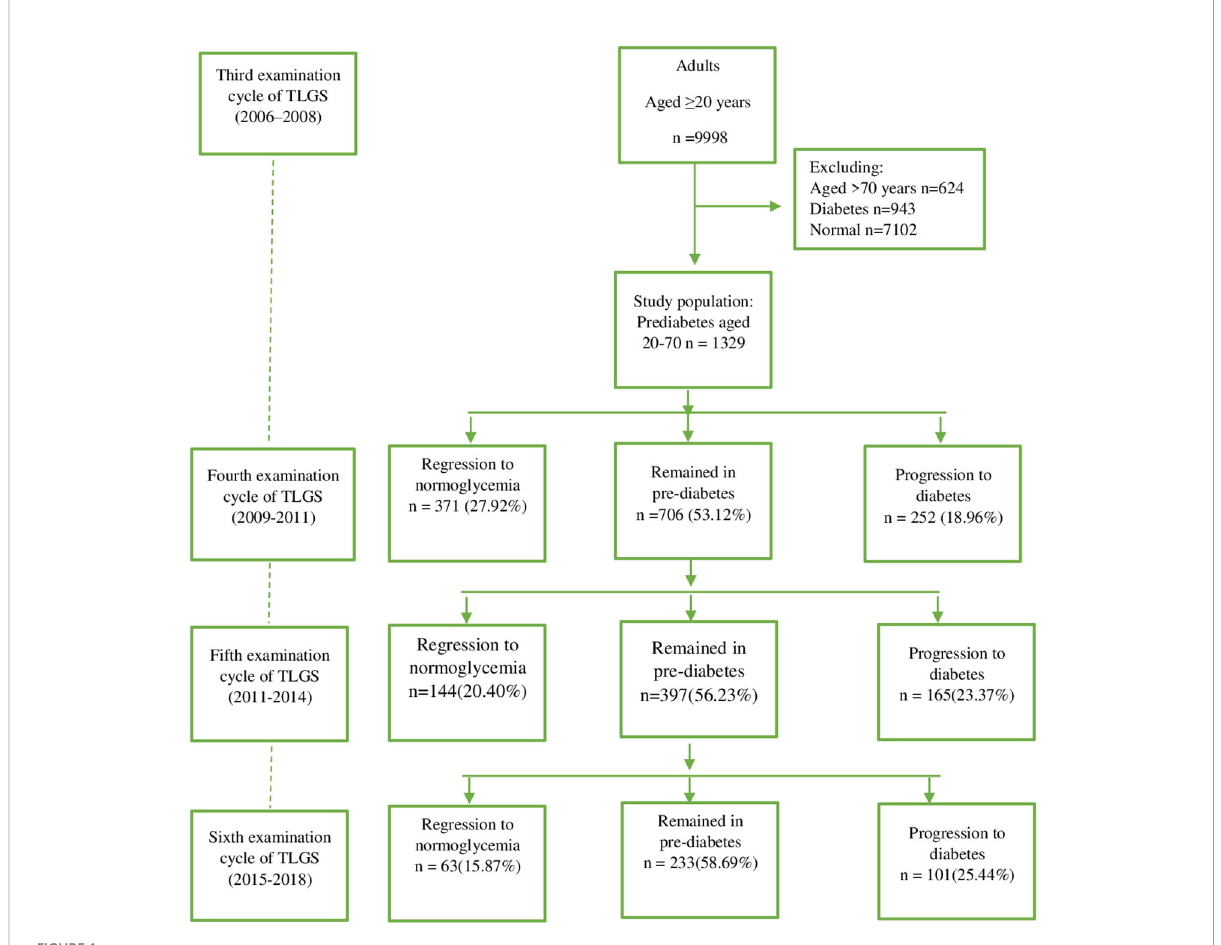
FIGURE 1 Flow diagram describing the study